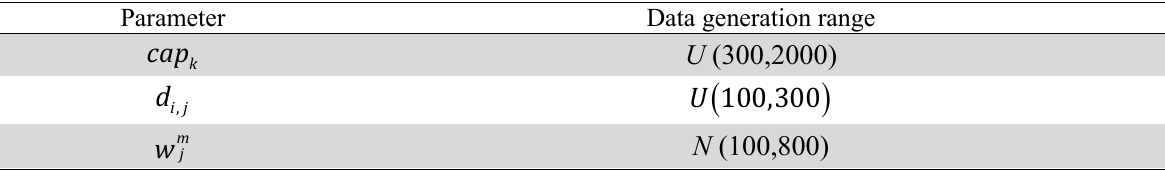
Data for illustrative